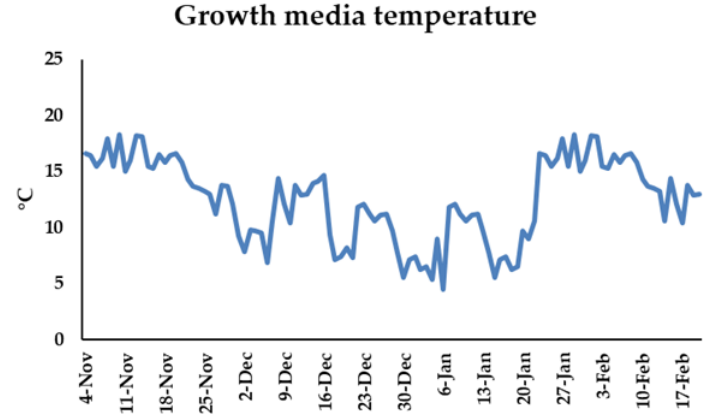
Figure 7. Growth media temperature (°C) during the experiment. Humidity and temperature were measured using a Testo 175H1 (Testo Romania, Cluj-Napoca, Romania). Recorded average humidity during the experiment was 80.9%, and the average temperature was 15.19 °C (Figure 8).